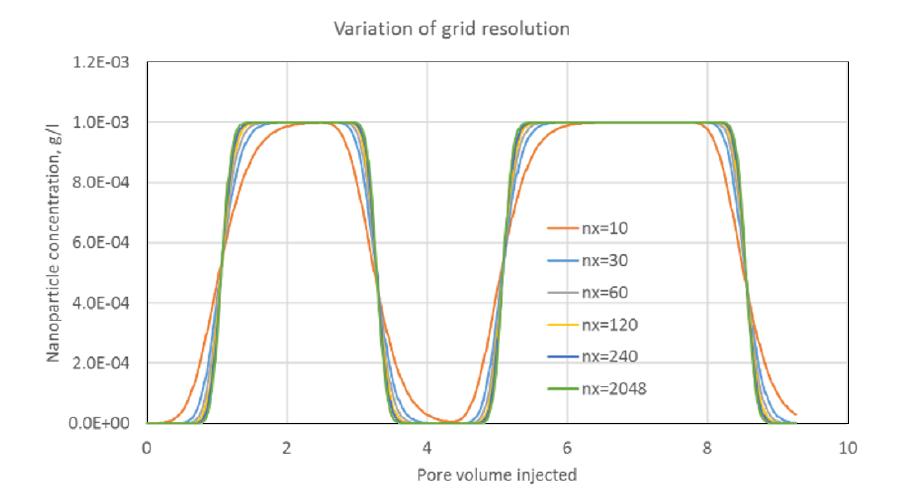
Figure 9. Concentration of nanoparticles as a function of injected solution: Sensitivity simulations varying number of grid blocks in the